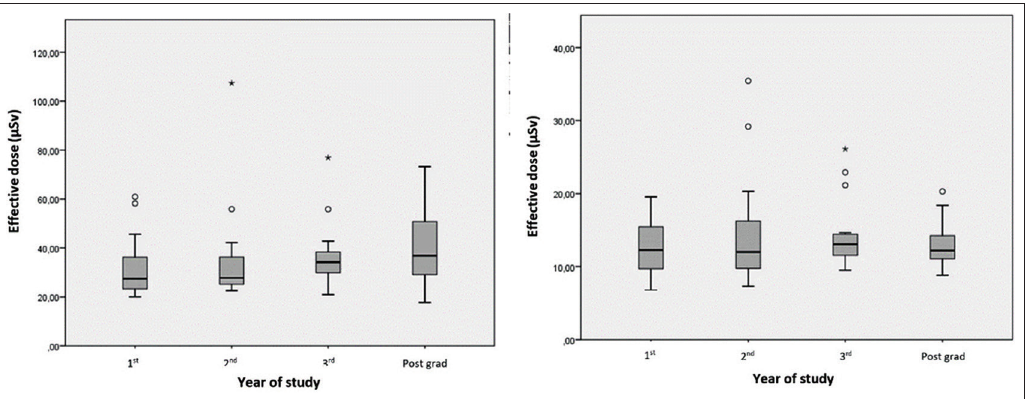
FIGURE 2. Effective dose comparison between study years for anteroposterior view (left) and lateral view (right) of useful images of the thoracic